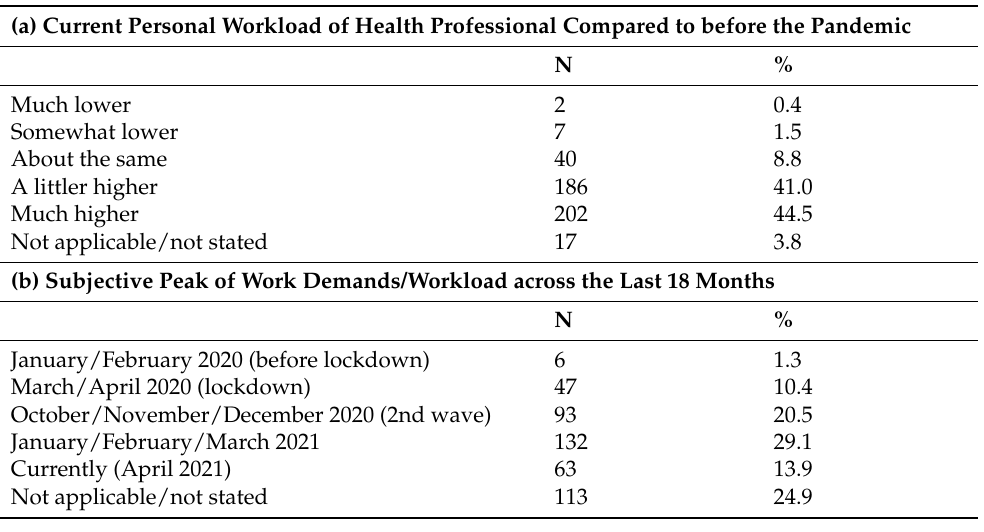
Table 4. Workload changes and workload peak during the pandemic.